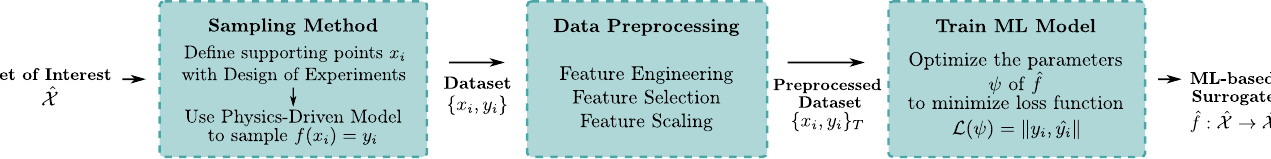
Figure 3. Fundamental workflow of machine-learning-based surrogate